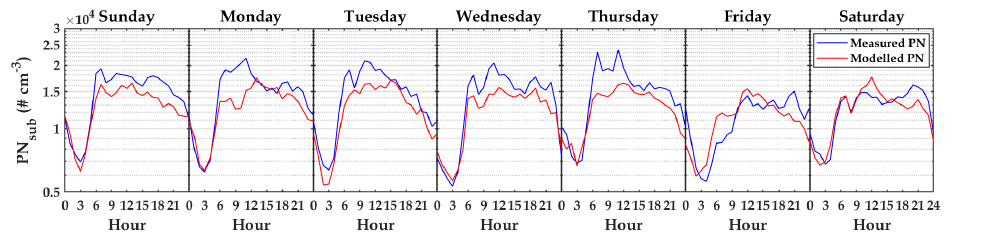
Figure 12. The median of diurnal cycles calculated on different days for measured PN and modeled PN (No. 26).